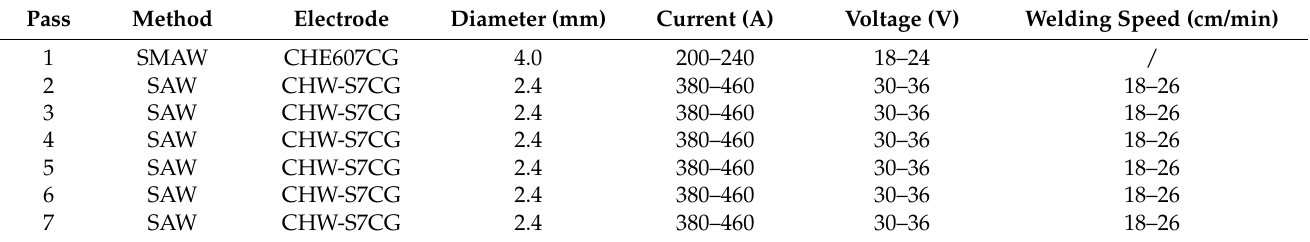
Table 3. Welding parameters.